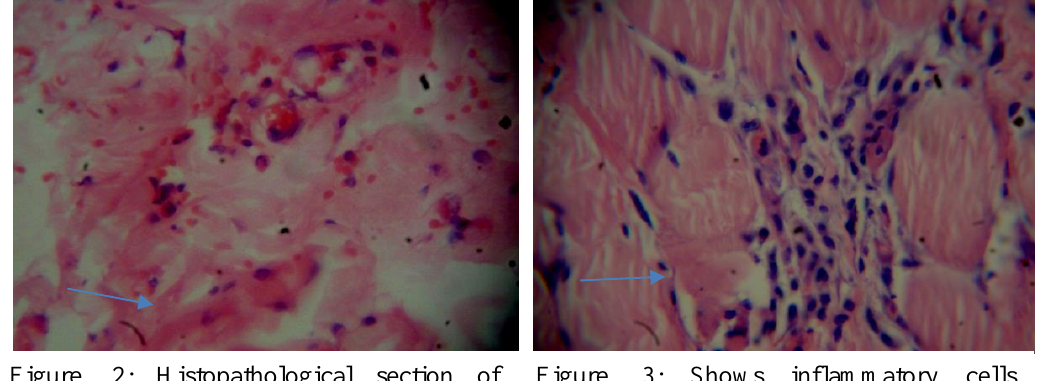
Figure, 2: Histopathological section of control group at one day postoperative revealed that neutrophils infiltration with necrosis (H&E 40X).